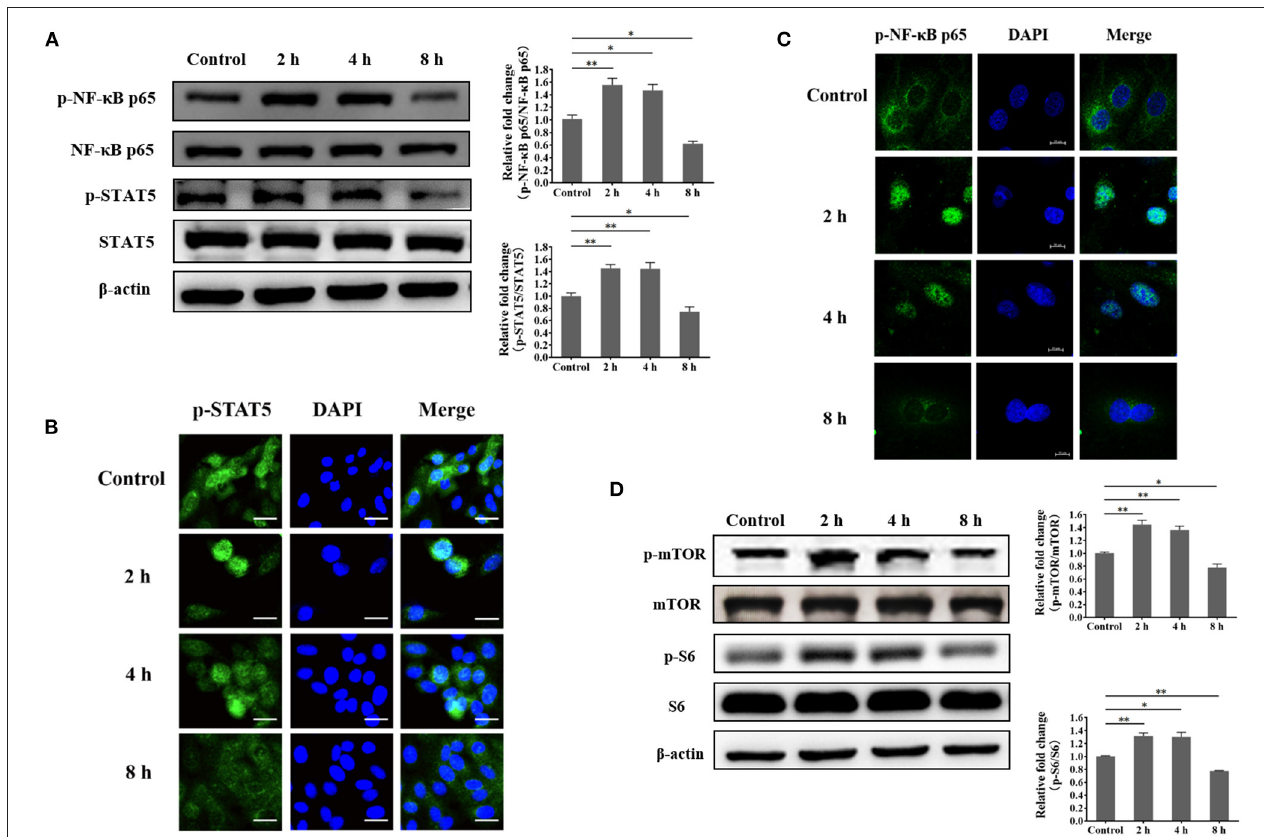
FIGURE 6 | Staphylococcus aureus infection suppresses the phosphorylation of NF- κ B p65, STAT5, mTOR, and S6 at 8h. (A) Phosphorylation of NF- κ B p65 and STAT5 in S. aureus -invaded BMECs. (B) Nuclear localization of phosphorylated STAT5 in S. aureus -invaded BMECs. Representative confocal microscopy images of the level of p-STAT5 (Green) in cells that were co-stained with DAPI (blue). Scale bars represent 20 µ m. (C) Nuclear localization of phosphorylated NF- κ B p65 in S. aureus -invaded BMECs. Representative confocal microscopy images of the level of p-NF- κ B p65 (Green) in cells that were co-stained with DAPI (blue). Scale bars represent 10 µ m. (D) mTORC1 signaling in S. aureus -invaded BMECs. The resolved bands were quantified using Gel-Pro Analyzer 4.0 (Media Cybernetics, Inc., Rockville, MD, USA). * p < 0.05; ** p < 0.01. n = 3 independent